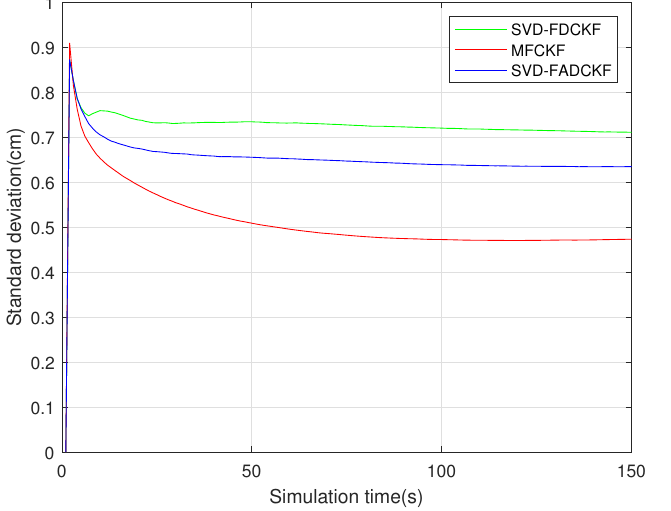
Figure 9. Average standard deviation of positioning error in 1500 Monte Carlo experiments (3